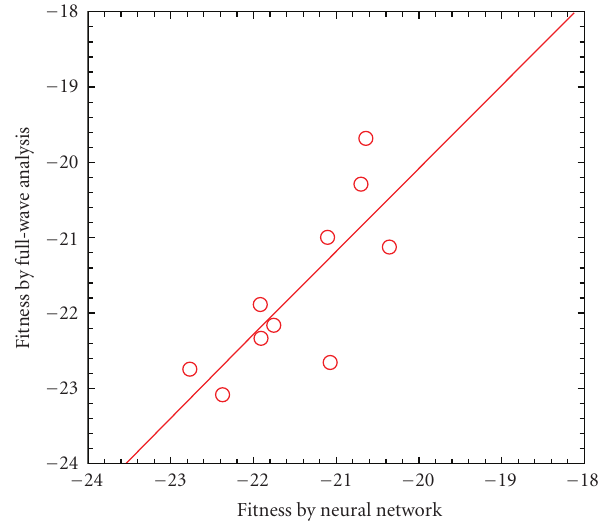
Figure 10: Prediction performance of the NN for the TM polarization absorber